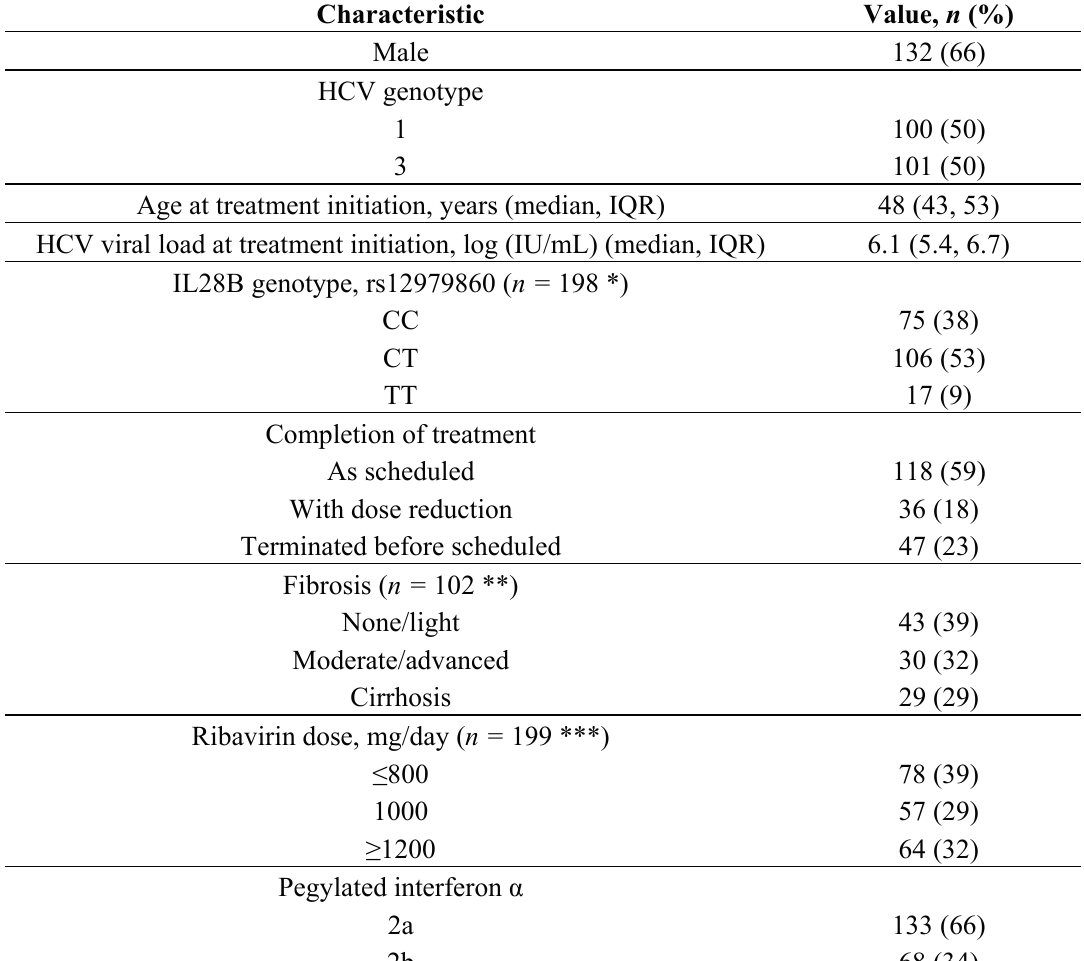
Table 1. Main characteristics of 201 individuals with chronic hepatitis C virus infection.